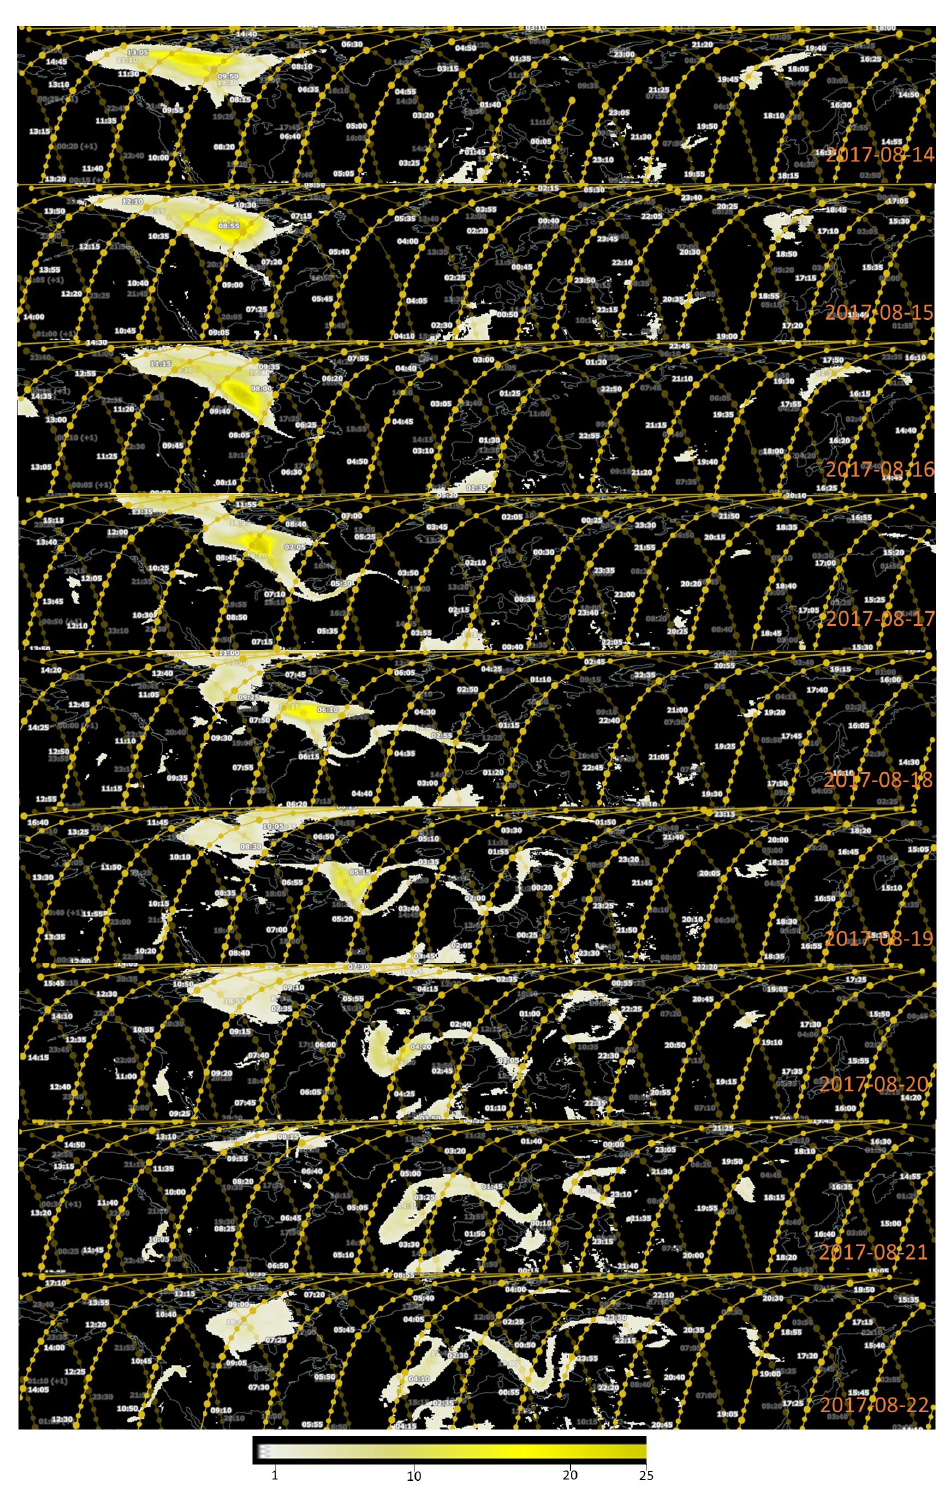
Figure 6. Daily OMPS-NM UV-absorbing aerosol index 14–22 August 2017 over all longitudes and latitudes 20–80 ◦ N. This index is sensitive to UV-absorbing aerosol particles in the upper troposphere and the stratosphere, where signals from tropospheric aerosol declines faster than from stratospheric due to short residence time. The yellow lines indicate nighttime swaths of the CALIPSO satellite, and the faint lines show CALIPSO daytime